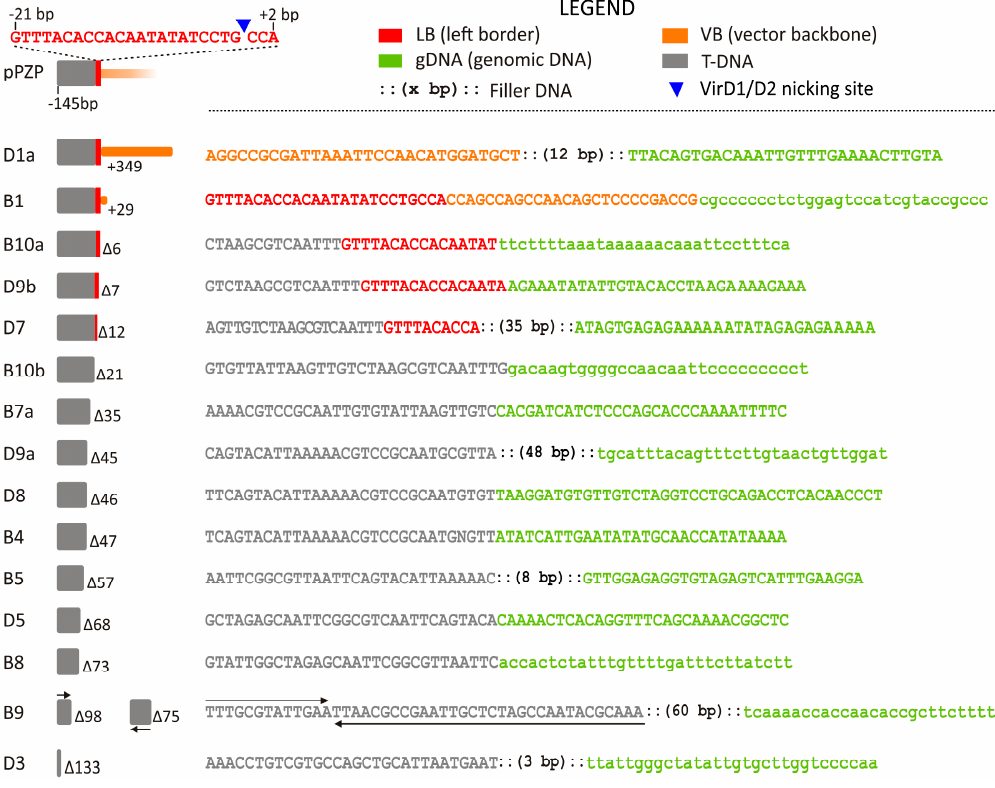
Figure 1. Analysis of left border (LB) junctions. Color codes are shown in the legend and the pPZP LB structure and sequence, in scale, is provided in the upper left corner. From left to right, each junction is described by: (1) an alphanumeric code identifying the transgenic event, if multiple junctions are isolated from the same event, these are identified by a lowercase letter; (2) a graphical representation, in scale, of the rearrangement occurred at the LB, along with the number of the deleted ( Δ ) or inserted (+) bp, in comparison with the expected intact transferred DNA (T-DNA) sequence (in one case T-DNA sequences with different orientations were detected, black arrows); (3) the sequence showing the 30 bp 5 ′ and 3 ′ of the junction; letters in lowercase indicate putative gDNA sequences (not verifiable by BLAST analysis, Table S1). Letters in red identify bases belonging to the LB.